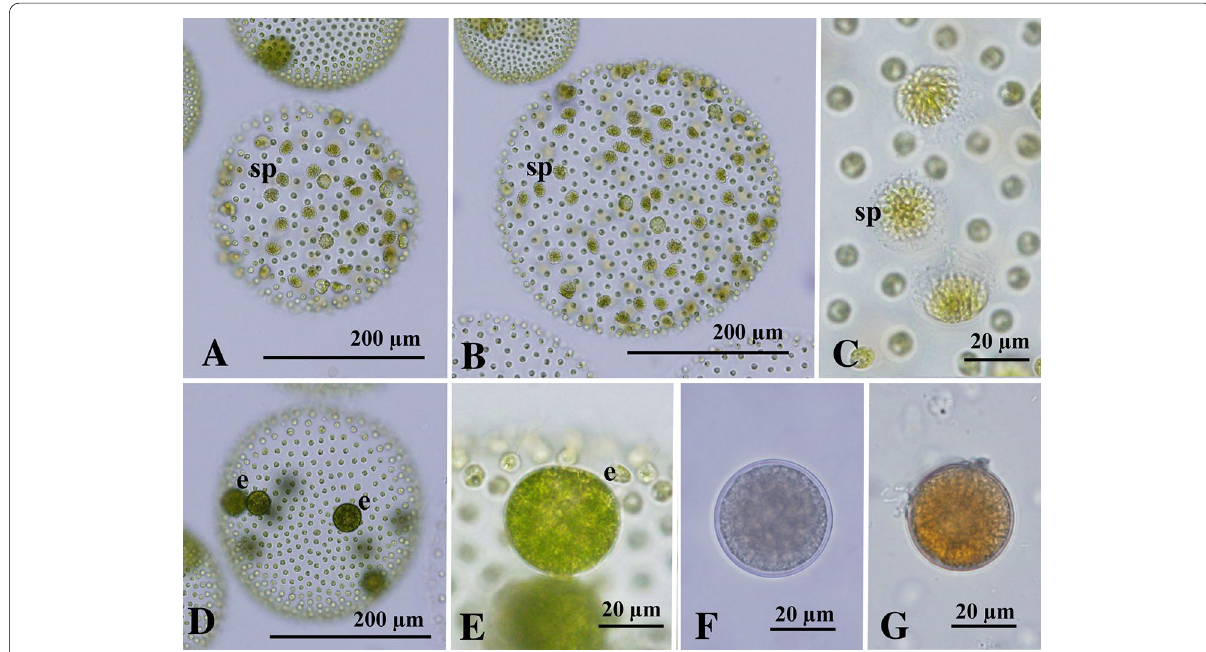
Fig. 2 Sexual spheroids of Volvox africanus G.S. West strains 1101-NK-1 ( A – F ) and 1101-NK-1 x 1101-NZ-11 ( G ) from Thailand. A – G Bright-field microscopy. A – C Male spheroids with sperm packets (sp). D , E Female spheroids with eggs (e). F , G Mature zygotes with a smooth cell